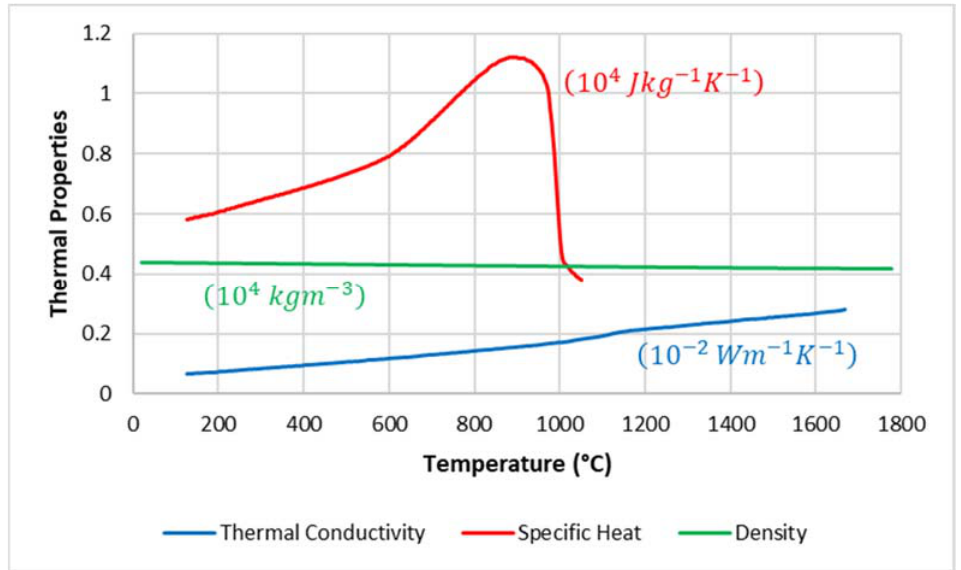
Figure 3. Chart displaying the following thermal properties as functions of temperature for Ti ‐ 64; thermal conductivity [18], specific heat capacity [18], and density [17].